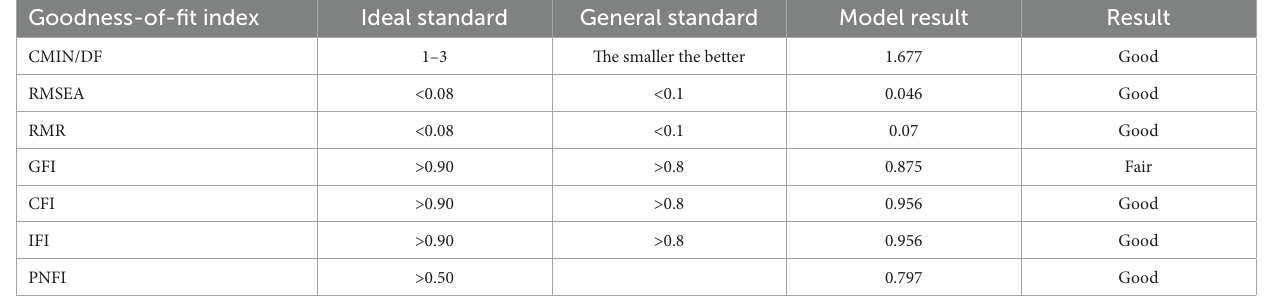
TABLE 3 Confirmatory factor analysis